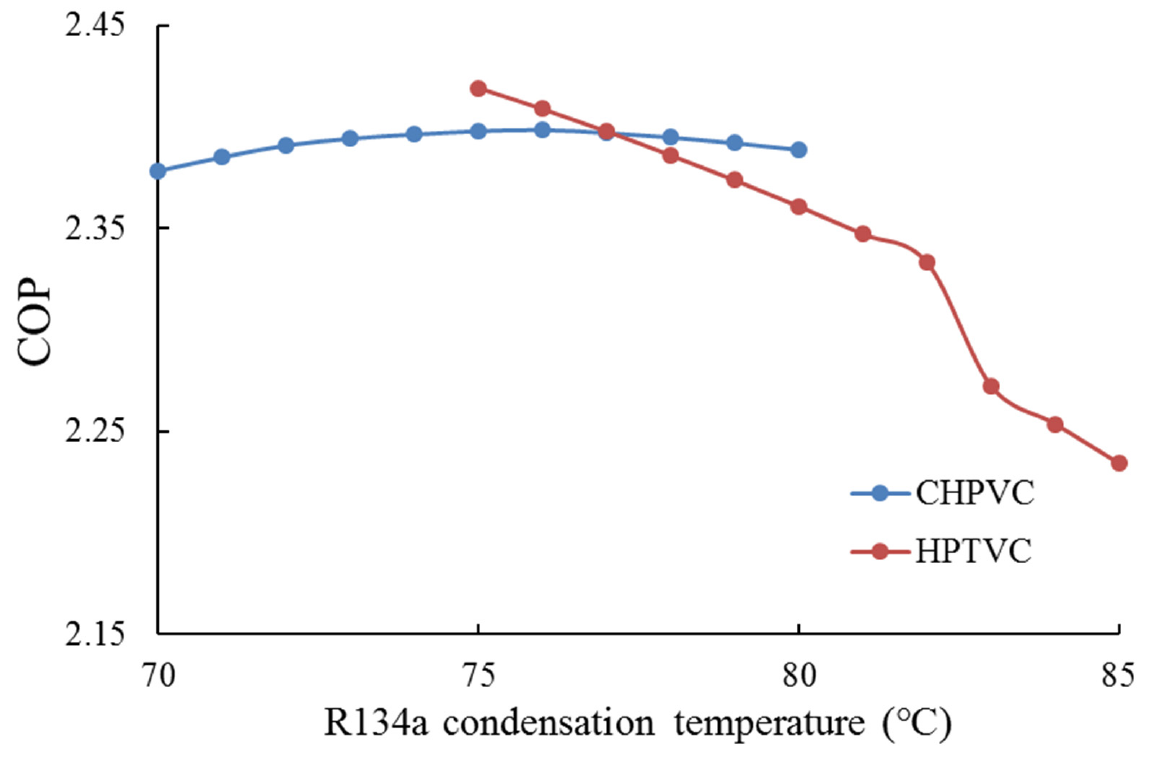
Figure 5. COP versus the R134a condensation temperature.